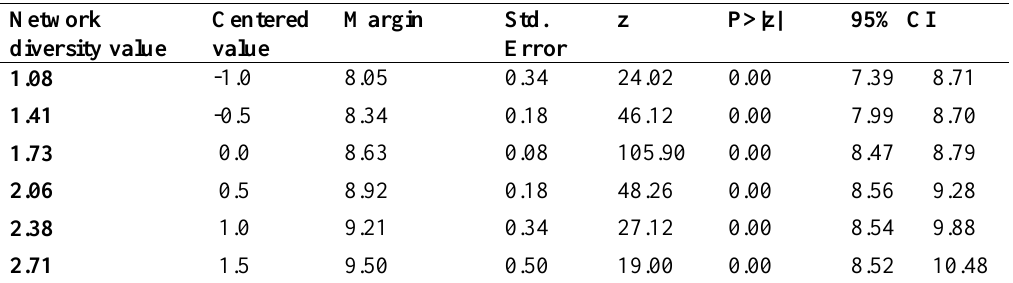
Table A1.4 Statistical significance for the predicted values (margins) of perceived success by network diversity Network diversity